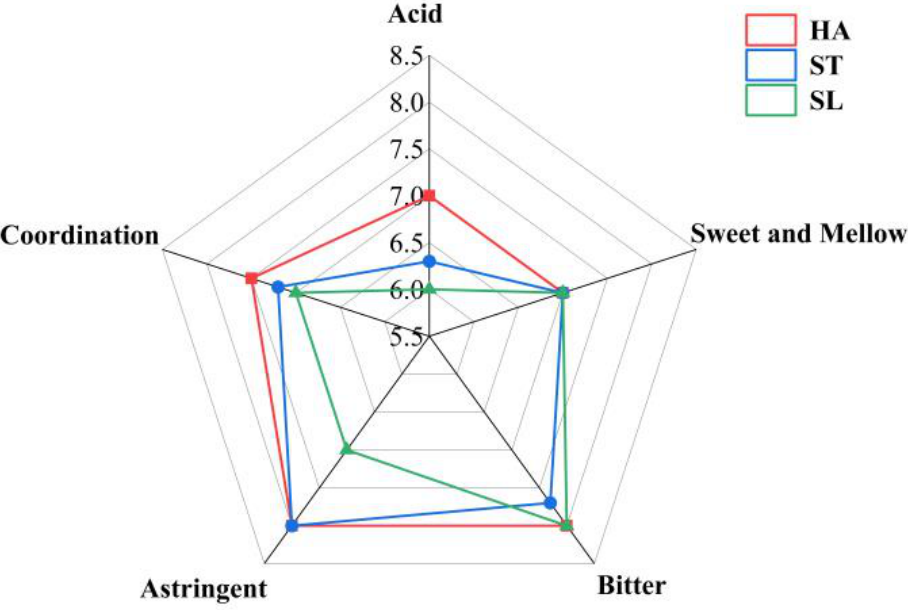
Figure 1. Radar chart of citrus tea taste factor scores for different fixing methods. In terms of sourness, HA showed significantly better performance than ST or SL, and ST was superior to SL. In terms of astringency, SL- and ST-fixed ODTs showed a more astringent taste. In terms of bitterness, HA showed better performance than ST or SL. In terms of coordination, HA showed the highest score, followed by ST, and SL had the lowest score. The coordination performance is jointly determined by various taste factors of the tea soup, so obvious sourness, bitterness, and astringency suggest poor taste coordination. SL and ST were lower than HA in sourness and astringency scores, so their taste coordination scores were also